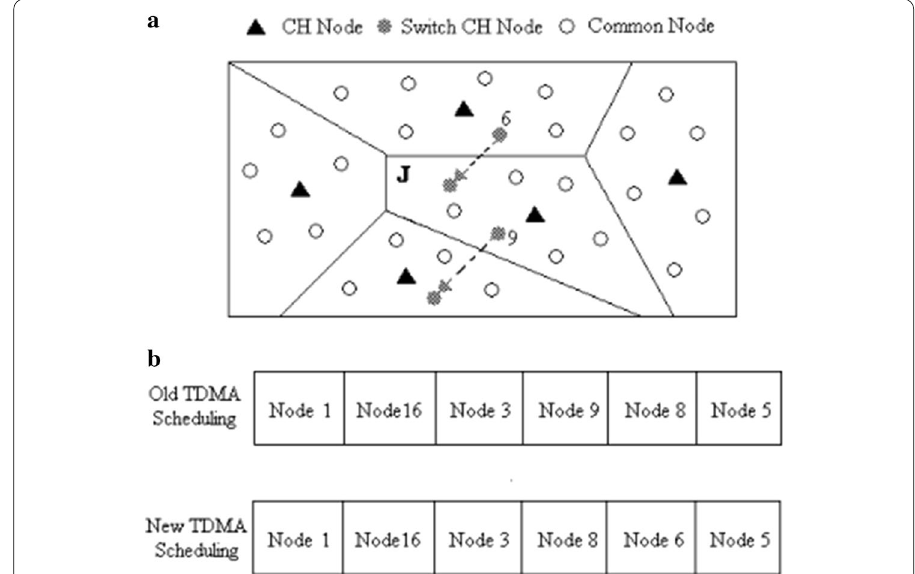
Fig. 4 The self-adaption sequence generation graph of